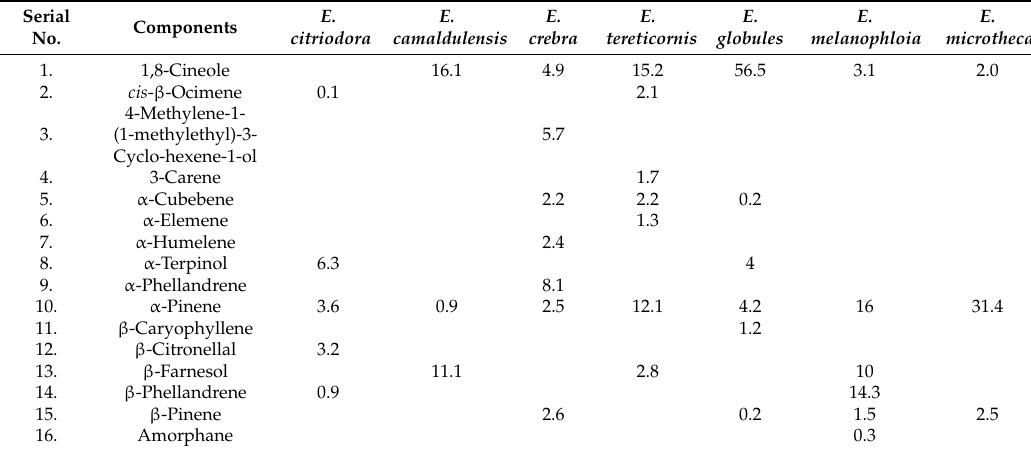
Table 2. Relative percentage chemical composition of essential oils of the EOs extracted from seven Eucalyptus